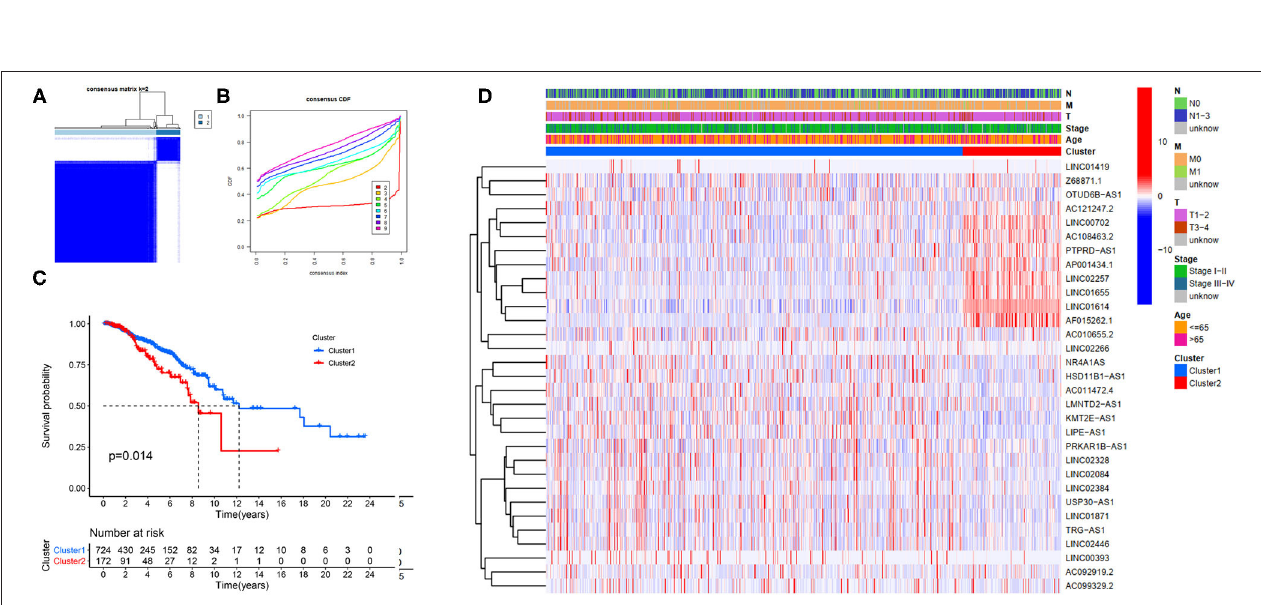
FIGURE 4 | Hierarchical consensus clustering based on the prognostic FRLncRNAs. (A) Consensus clustering analysis identification of two clusters ( n = 896); (B) Cumulative distribution function (CDF) for k = 2–9; (C) Kaplan–Meier (K–M) curves for the 896 patients breast cancer (BC) stratified by cluster; (D) Heatmap on the prognostic FRLncRNAs ordered by clusters. The association with clusters, survival probability, and clinical information (age, stage, T stage, N stage, and M stage) were investigated.